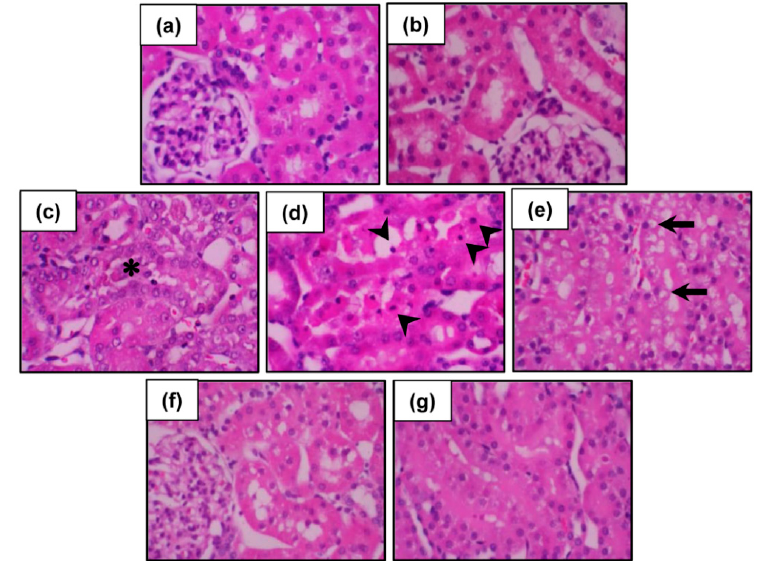
Figure 3. Photomicrographs of the kidneys following cadmium and CNFE treatments. Kidney tissues from ( a ) control and ( b ) CNFE-treated groups showing essentially normal tubules. In the Cd-treated group ( c – e ), severe tubular necrosis (asterisk), apoptosis (arrowhead), and vacuolar degeneration (arrow) were observed. Treatment with CNFE either at 1 g/kg ( f ) or 2 g/kg ( g ) markedly ameliorated all renal damages caused by cadmium. Hematoxylin and eosin (H & E), 40×.